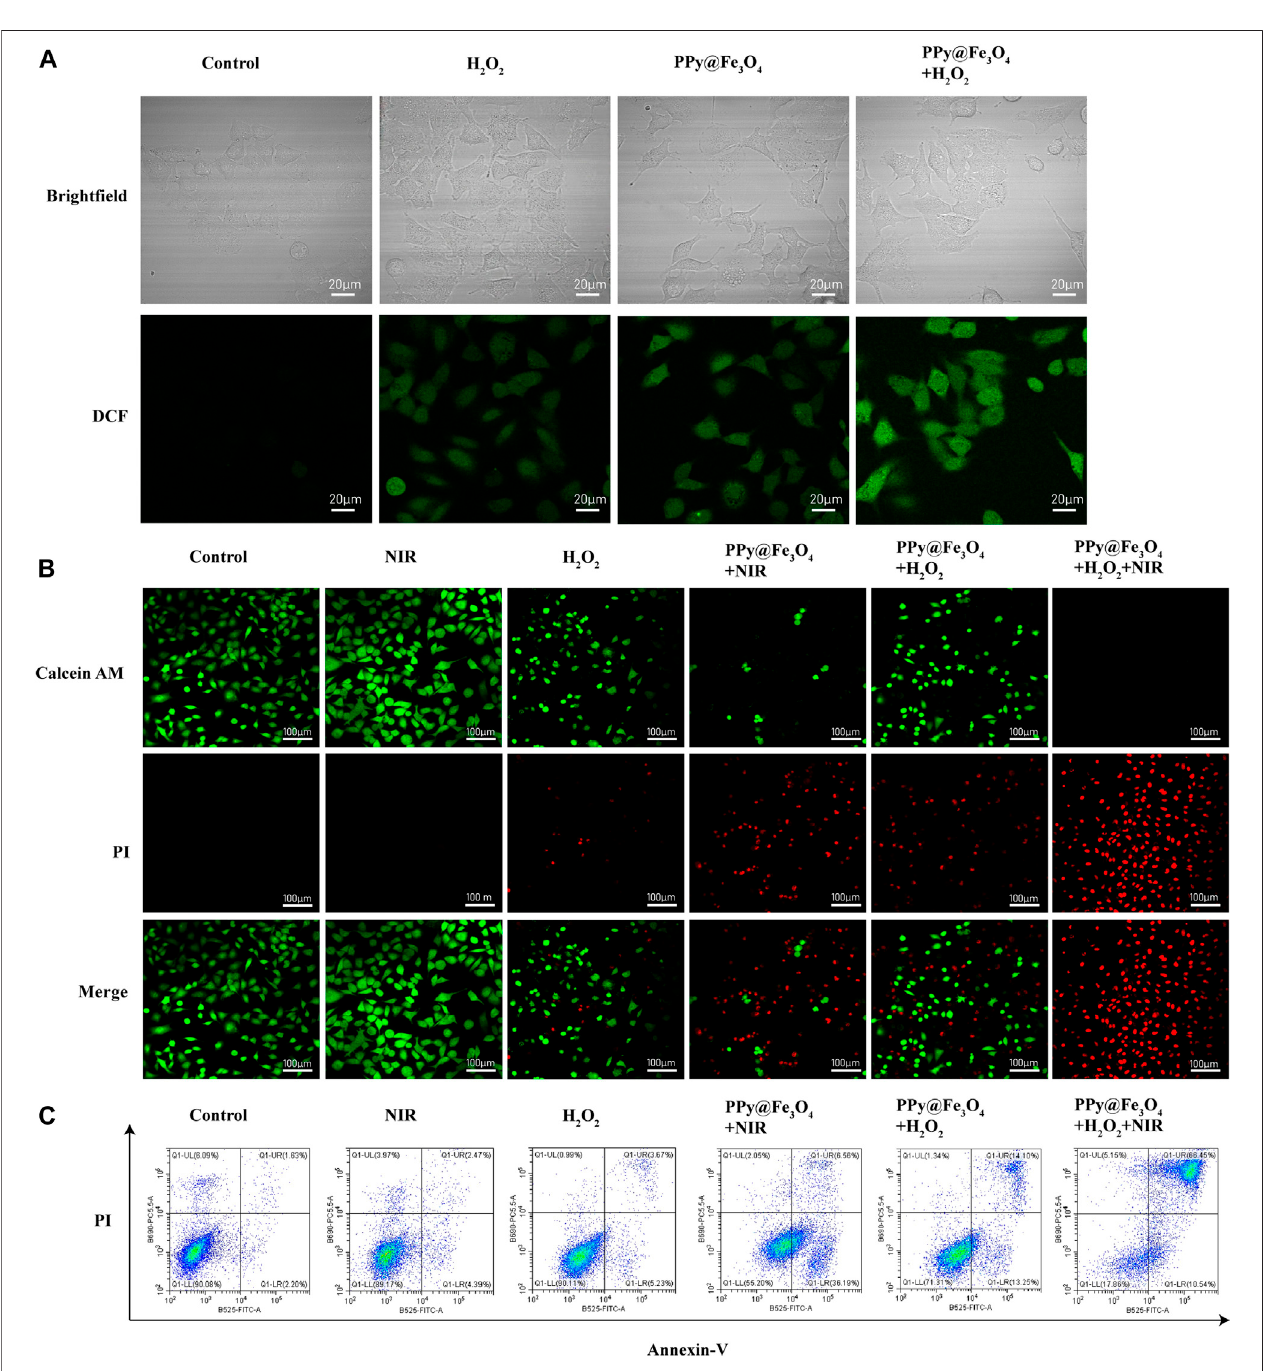
FIGURE 4 | The PPy@Fe 3 O 4 NPs increase intracellular ROS generation induced by H 2 O 2 and induce cell apoptosis. (A) Bright fi eld images and confocal images of ROS level in A549 cells. (B) Confocal images of Calcein-AM and PI co-stained A549 cells in different groups. Scale bar, 100 μ m. (C) Cell apoptosis measured by fl ow